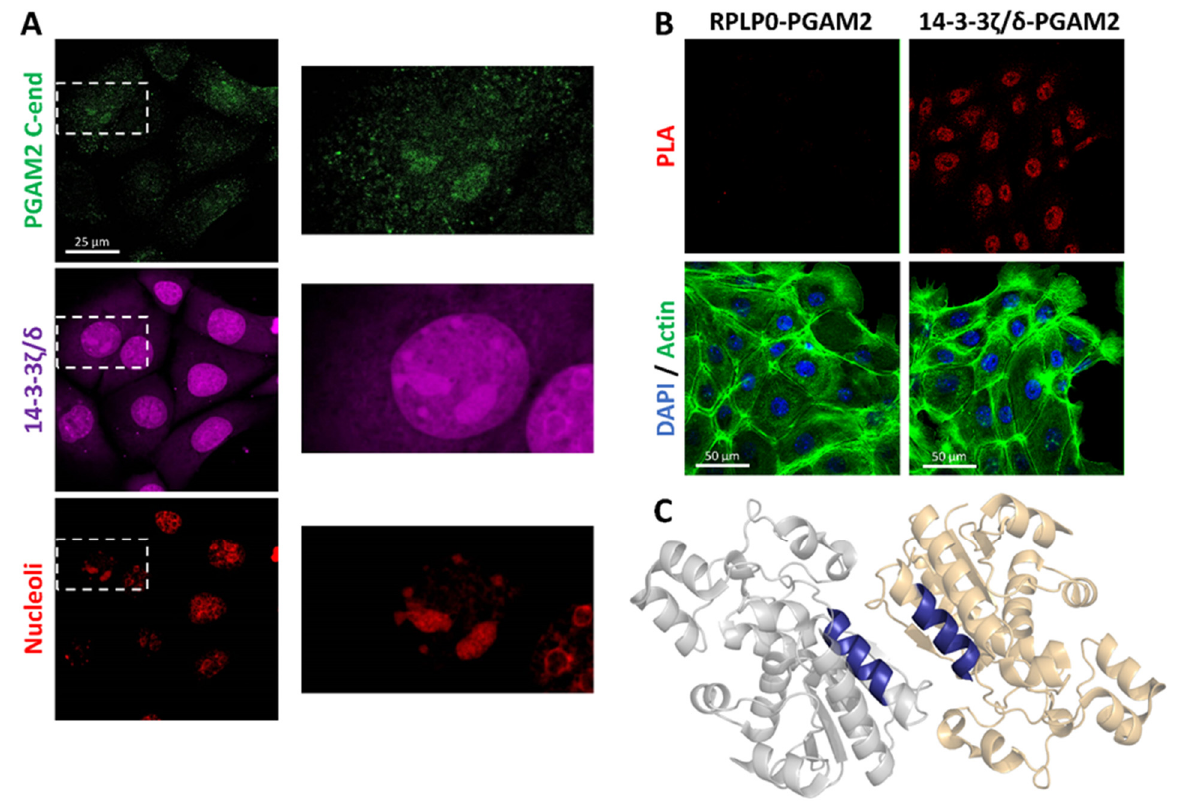
Figure 5. In vivo detection of PGAM2 interaction with RPLP0 and 14-3-3 ζ / δ . ( A ) PGAM2 co-localizes with 14-3-3 ζ / δ in the nucleoli, as determined using propidium iodide counterstaining. ( B ) Proximity ligation assay (PLA) did not show the presence of RPLP0–PGMA2 interaction within the cells. On the other hand, 14-3-3 ζ / δ –PGAM2 complexes were observed, mainly in the cellular nuclei. ( C ) Hypothetical 14-3-3–binding site on the surface of PGAM2 dimer (gray and orange, PGAM2 subunits; blue, PGAM2 sequence: 60LKRAIRTLWAI70 which may recognize 14-3-3 proteins.